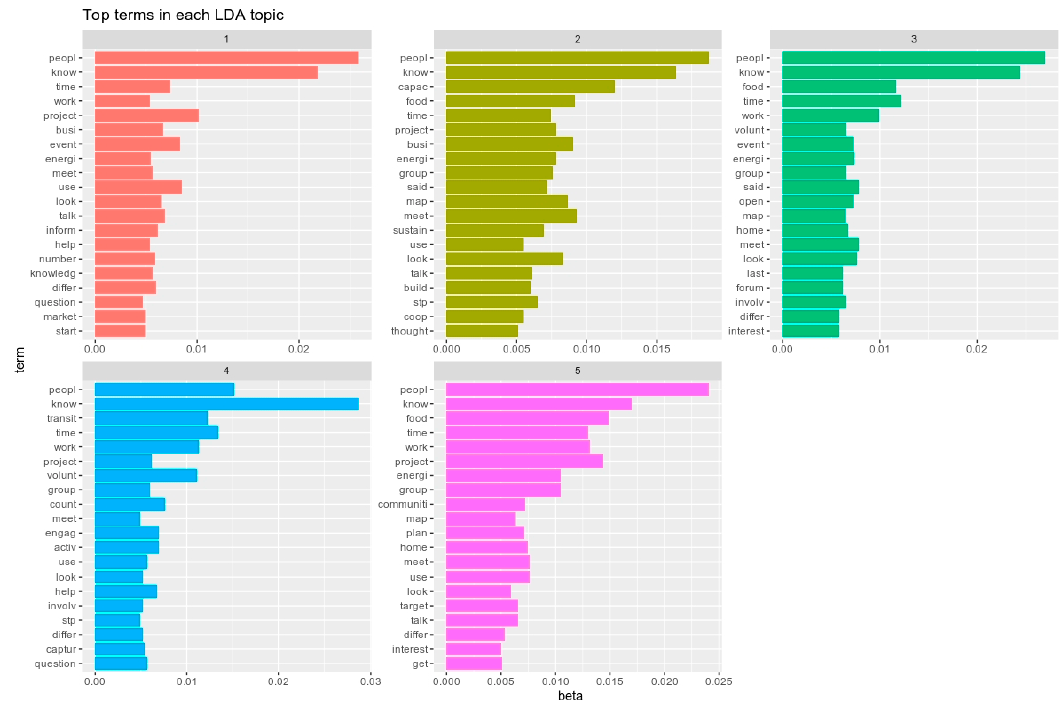
Figure 1. LDA topic modeling (k = 5).